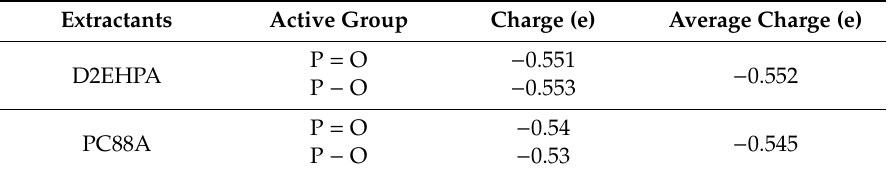
Table 5. Charge properties of PC88A and D2EHPA.